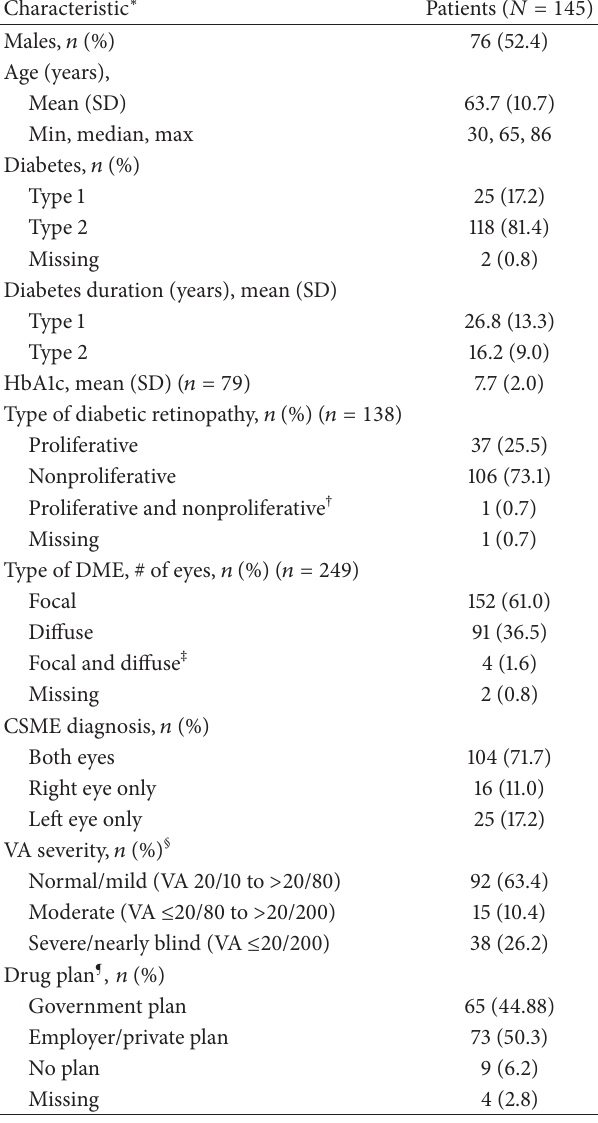
Table 1: Baseline patient